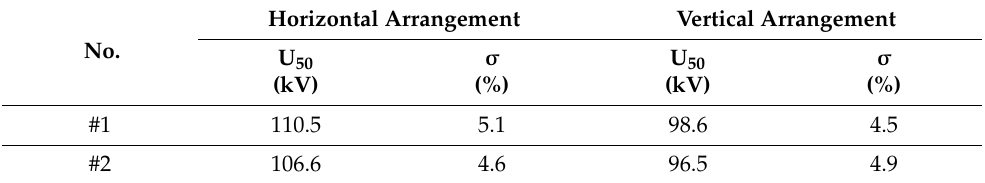
Table 7. Influence of arrangement on pollution flashover test results of composite crossarm